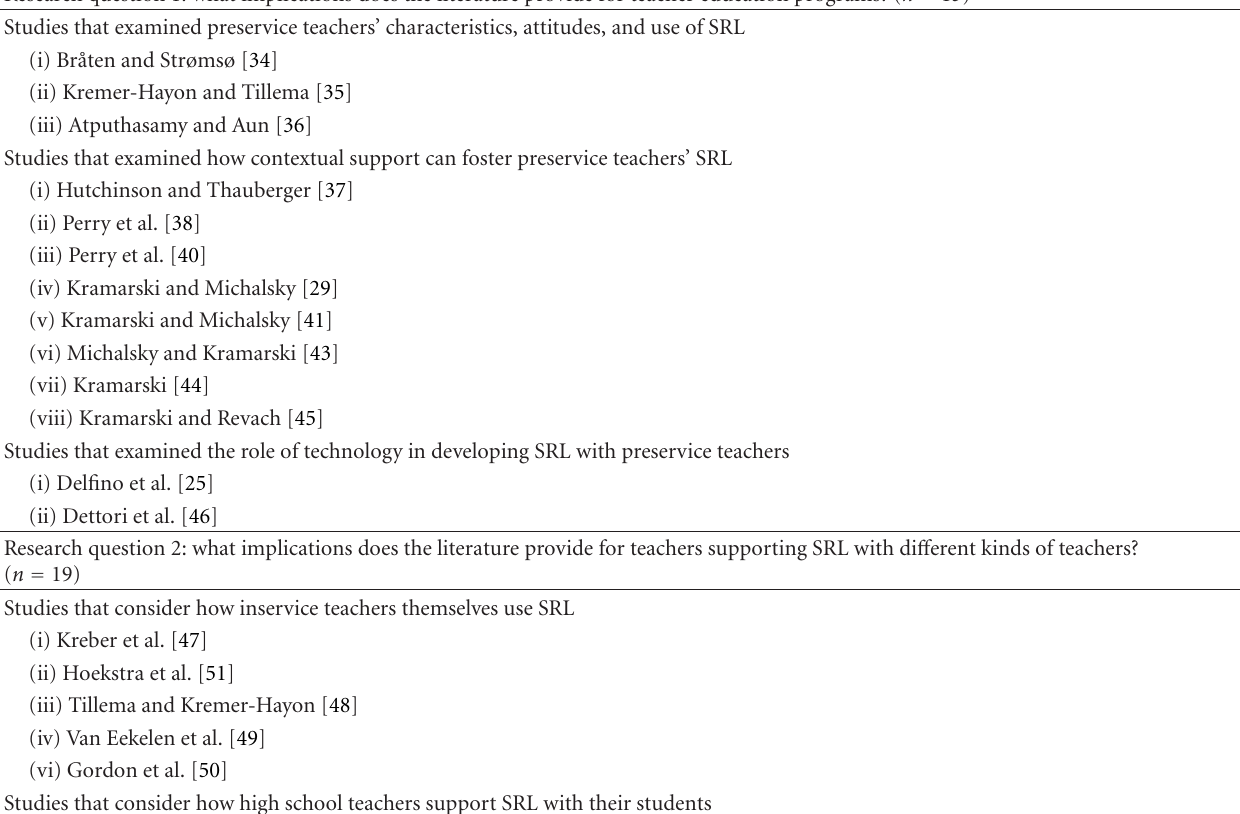
Table 1: Complete list of reviewed studies by research